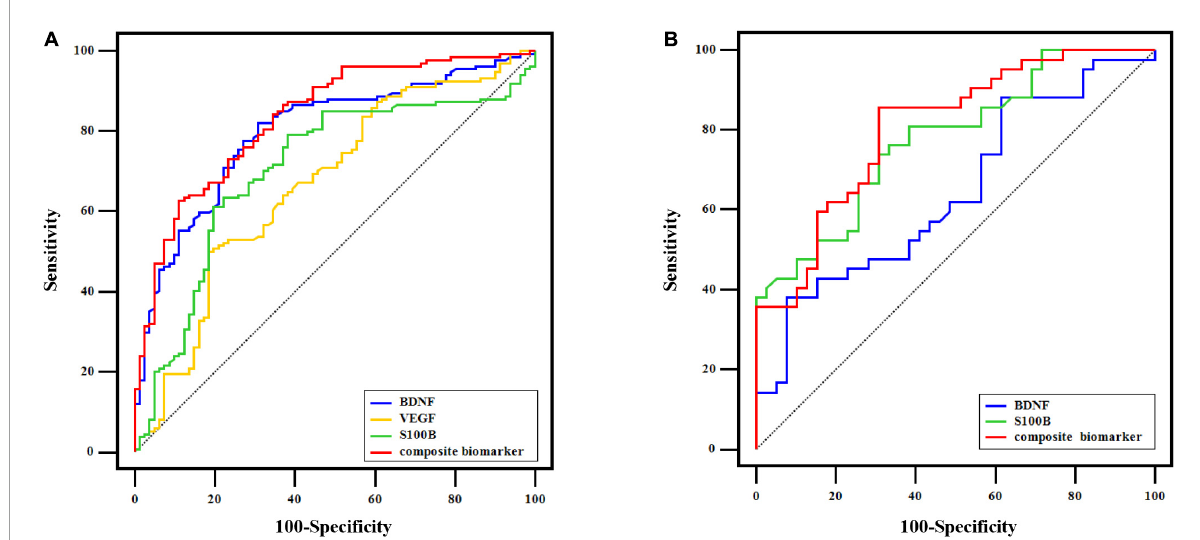
FIGURE4 ROC curve analysis. (A) In 215 OA participants, ROC curves of BDNF, VEGF, S100B, and the composite biomarker of their combination for distinguishing MDD from control at baseline. (B) ROC curves of baseline BDNF, baseline S100B, and the combination of the two indicators to distinguish OA participants who transformed into MDD from those with non-MDD after the